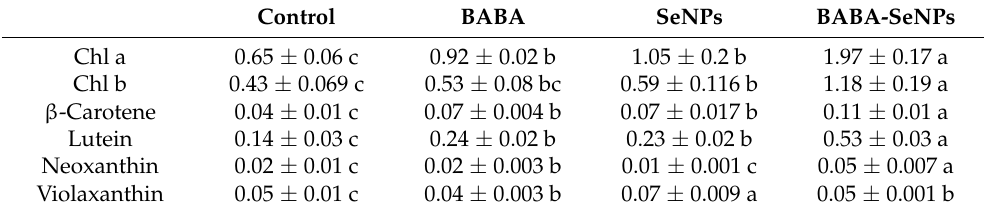
Figure 1. Biomass; fresh weight (FW) (mg g − 1 FW) and dry weight (DW) (mg g − 1 FW); photosynthesis ( µ mol CO 2 m − 2 s − 1 ); and respiration of control in BABA- and/or SeNPs-treated M. interexta sprouts. Data are represented by the means of four replicates ± standard deviations. Different small letter superscripts (a–d) within a row indicate significant differences between control and BABA and/or SeNPs samples. One-way analysis of variance (ANOVA) was performed. Tukey’s test was used as the post hoc test for the separation of means ( p < 0.05). Table 1. Pigment content (chlorophyll a + b ) (mg g − 1 FW) of control and BABA- and/or Se NPs-treated M. interexta sprouts. Data are represented by the means of four replicates ± standard deviations.